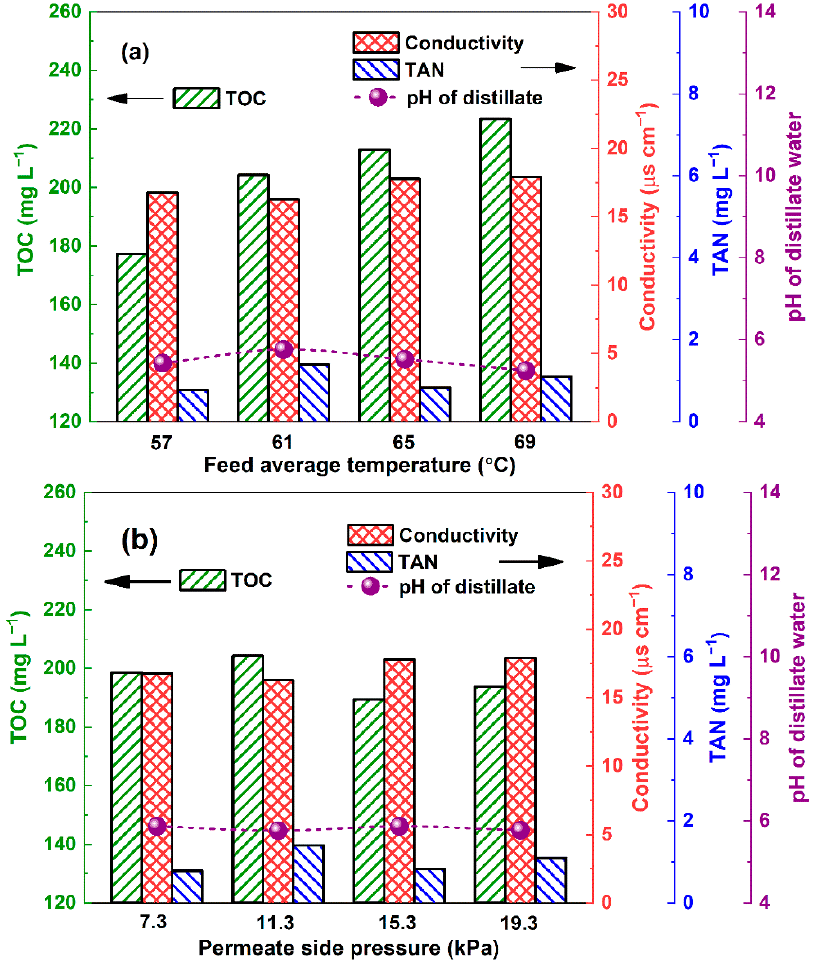
Figure 3. Change in TOC and TAN concentrations as well as conductivity and pH in distillate water with feed average temperature ( a ) and permeate side pressure ( b ) (permeate side pressure for former test: 11.3 kPa; feed average temperature for latter test: 61 °C, initial pH of feed: 1.6).